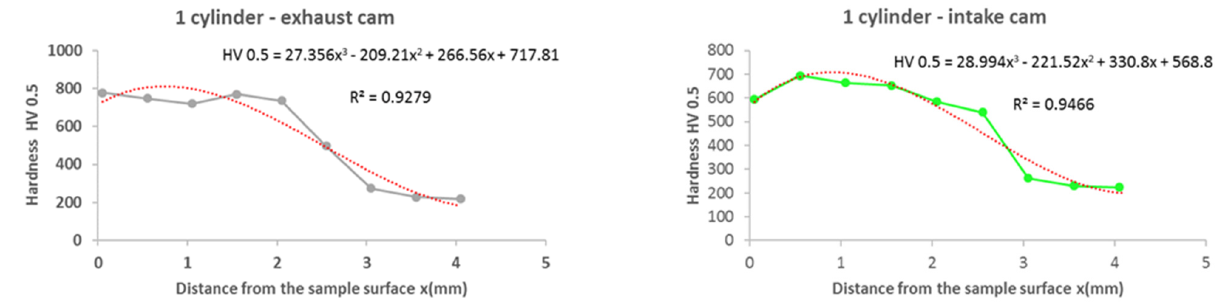
Figure 13. Regression analysis for a 3rd − order polynomial for the values of the 1st cylinder on the exhaust and intake cams.